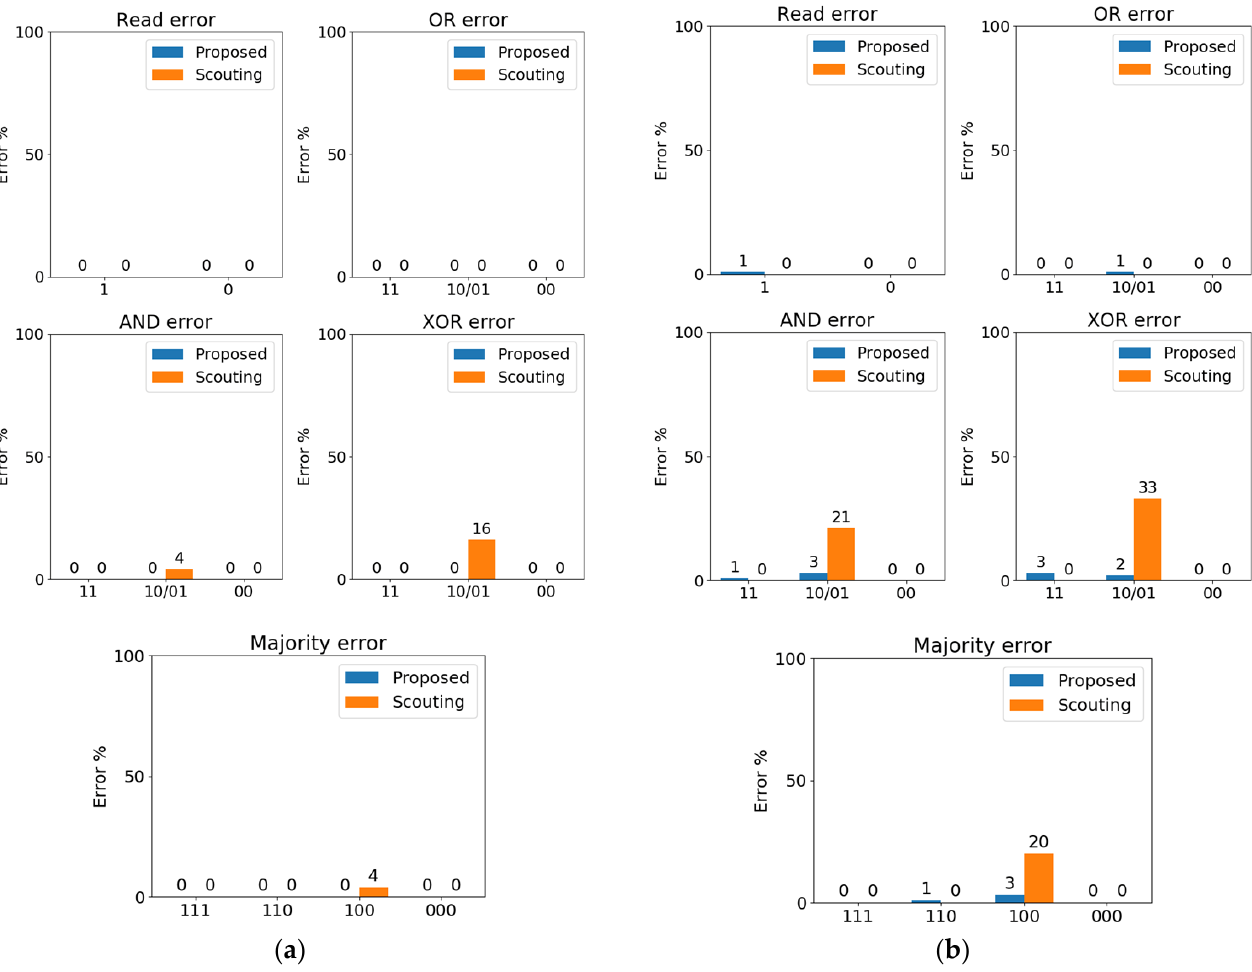
Figure 5. Performance evaluation results for the original “Scouting” SA and the “Proposed” SA circuit, showing the error percentage observed in 100.000 samples for each input combination, for memory and logic operations. Results concern ( a ) 10% and ( b ) 20% SD for the HRS and LRS distributions with mean values HRS/LRS = 125 G Ω /125 K Ω .